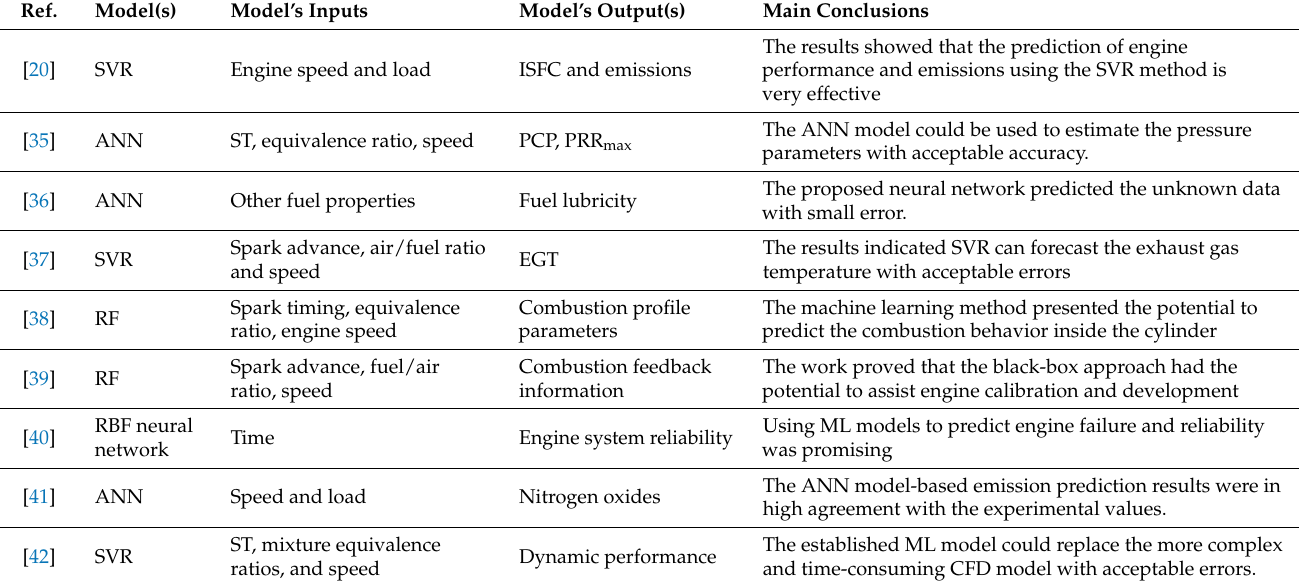
Table 1. Various ML models for engine related metrics